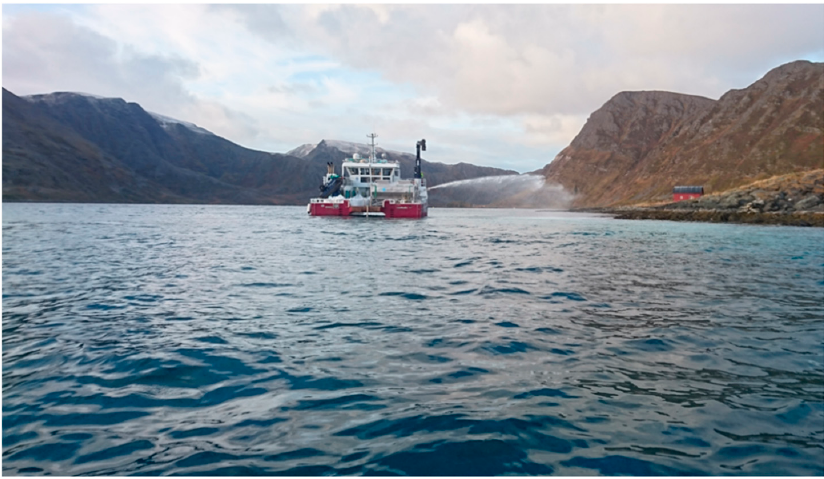
Figure 18. Photo of the boat spraying lime suspension of coarse CaO over the sea.